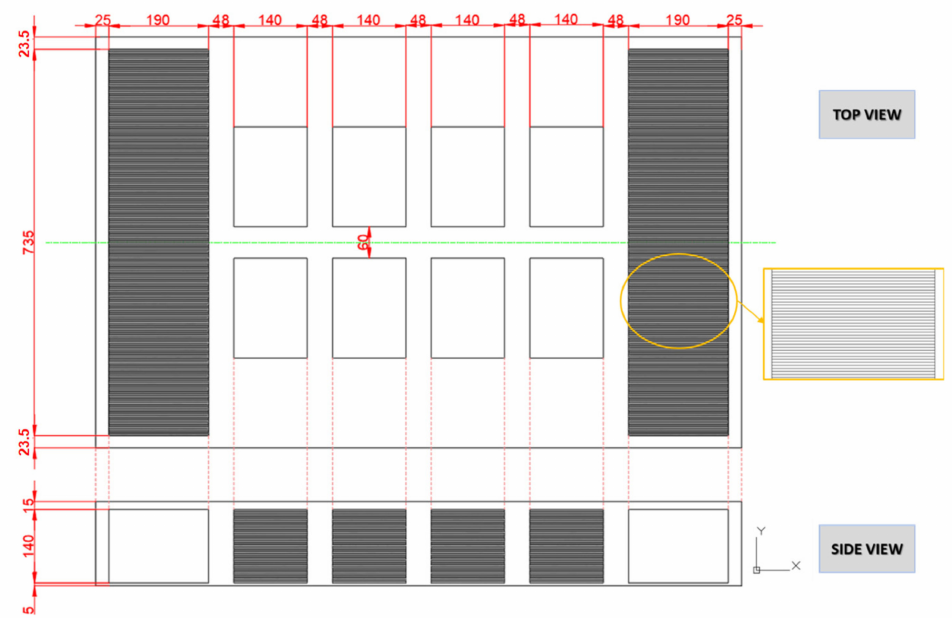
Figure 10. Pack schematic of configuration 8 with BLB2 pouch cells in the floor integration installation of reference vehicle.